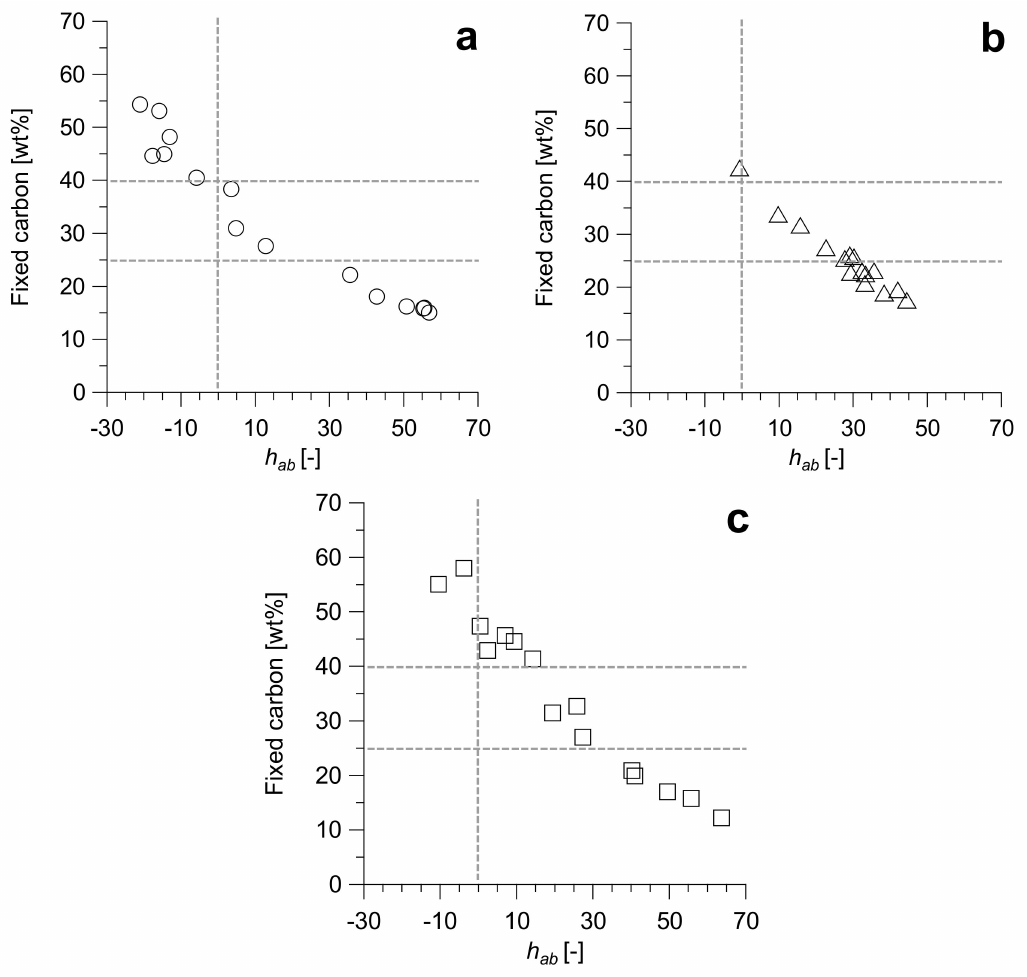
Figure 3. Relationship between the h ab and fixed carbon content. ( a ) Rubber tree; ( b ) softwood bark; ( c )